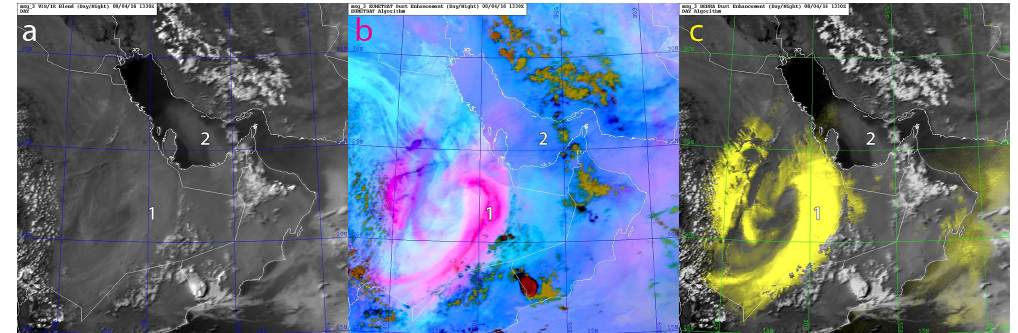
Figure 1. Meteosat Second Generation-8 satellite imagery on 4 August 2016 at 13:00 for (a) visible reflectance, and infrared-based significant dust enhancements from (b) EUMETSAT (dust is represented by the color magenta), and (c) DEBRA (dust is represented by the color yellow) algorithms. The label “1” on each panel denotes the well-detected overland dust plume, while the label “2” denotes the overwater portion of a significant dust plume that was missed by the infrared-based dust detection methods. Here, the missing dust plume is only evident in visible imagery (a) due to its high contrast against the relatively dark ocean background.